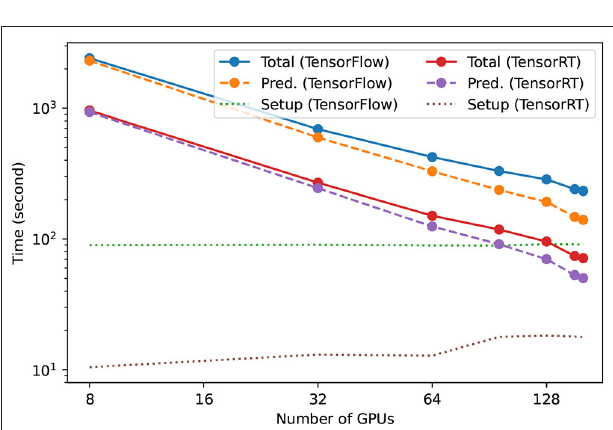
FIGURE 7 | Scaling of accelerated inference in ThetaGPU. TensorRT AI ensembles accelerate gravitational wave detection by 3fold when compared to traditional AI ensembles (labeled as TensorFlow ). TensorRT AI ensembles process an entire month of advanced LIGO data, including both Hanford and Livingstone strain data, within 50 s when AI inference is distributed over 160 NVIDIA A100 Tensor Core GPUs in the ThetaGPU